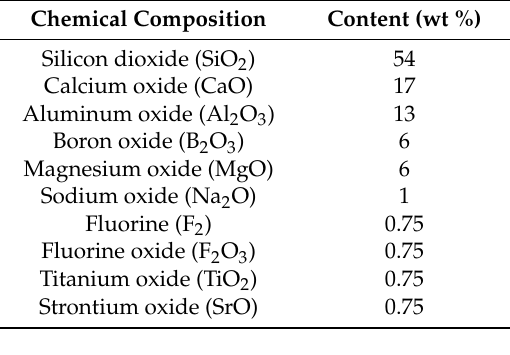
Table 3. Chemical components of milled glass fibers (MGFs).